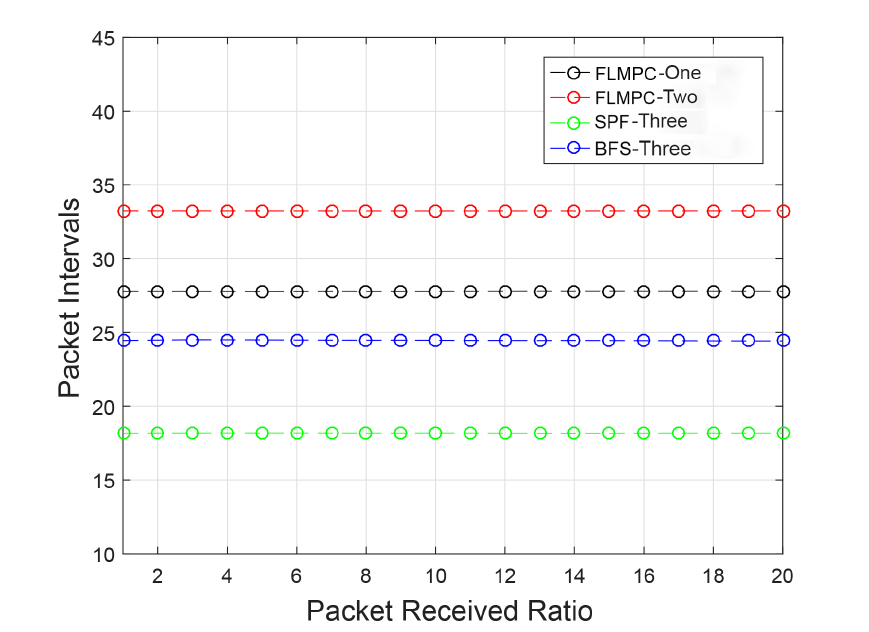
Figure 12. PRR of All